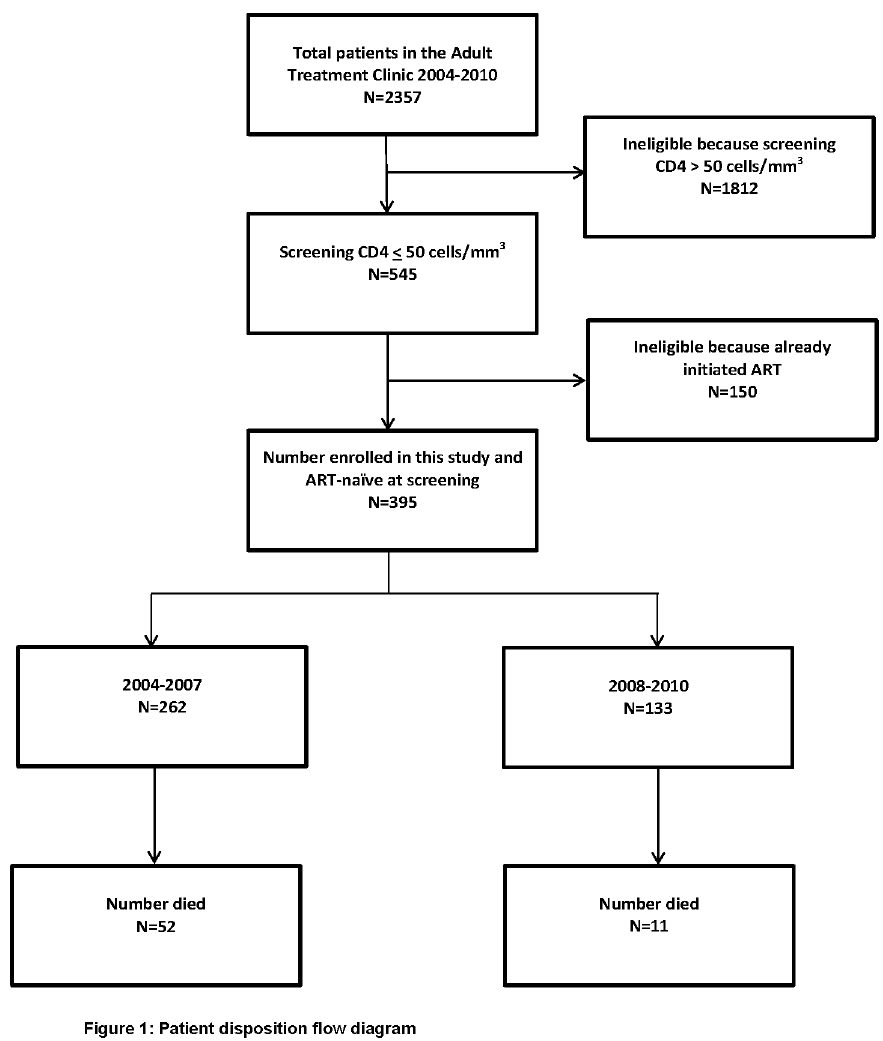
Figure 1. Patient disposition flow